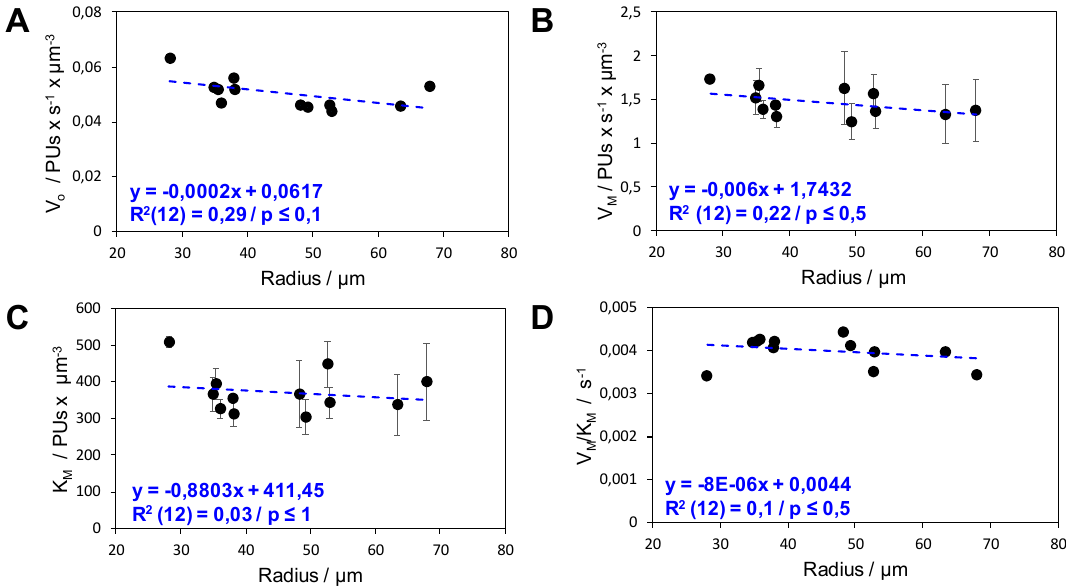
Figure 3. Effect of the particle radius on the kinetic parameters of the immobilized FDH and NAD + using formic acid as substrate. For single particle analysis, apparent V 0 ( A ), V M ( B ), K M ( C ), and V M /K M ( D ) were determined and plotted against the radius of each particle (circles). Errors for apparent V M and K M were calculated from three different iterations of PCAT using a different input data set. The dashed blue line represents the linear correlation between each kinetic parameter and the particle radius. Linear regression equations are shown within each graph. The multiple correlation coefficient R 2 and the p were calculated with an ANOVA statistical analysis. The number of samples is indicated in brackets beside the R 2 value.